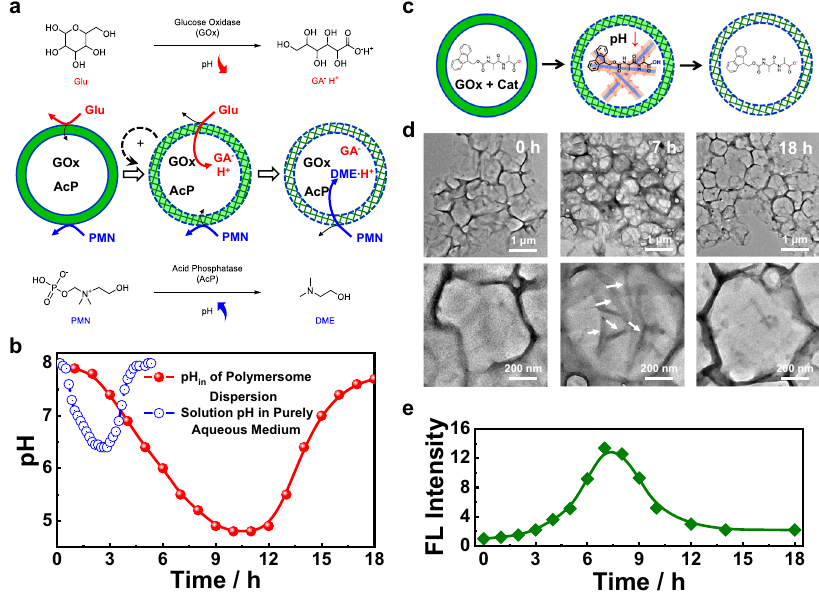
Fig. 5 Enzymatically regulated nanosystems for transient dipeptide self-assembly. a Schematics of generating transient local acidic milieu within polymersome interiors by kinetically and temporally coordinating two types of enzymatic reactions with opposite pH-tuning directions: GOx converts glucose into gluconic acid (GA), leading to pH decrease, bilayer crosslinking and permeabilization, and enhanced glucose in fl ux (i.e., positive feedback); at later stages, zwitterionic PMN, with higher molar mass compared to glucose, starts to diffuse through bilayers and catalytically generate alkaline DME by acid phosphatase (AcP), leading to pH increase and concomitant enzymatic activity decrease for both GOx and AcP (i.e., negative feedback). b Evolution of pH in recorded for BPN 23 polymersome dispersion encapsulating GOx and Cat upon addition of glucose (5 mM) and PMN (12 mM); the homogeneous solution mixture containing GOx and Cat was also examined for comparison. The initial pH was both set at 8.0. c Feedback-controlled transient acidic milieu of polymersome interiors for temporally programming the self-assembly of Fmoc-AA-OH dipeptide within polymersomes. Evolution of TEM images ( d ) and fl uorescence emission intensities ( λ ex = 405 nm, λ em = 480 nm, e ) recorded for BPN 23 polymersomes encapsulating GOx, Cat, Thio fl avin T (ThT), and Fmoc-AA-OH dipeptide in the presence of external PB buffer (pH 7.4, 30 mM) upon addition of 10 mM